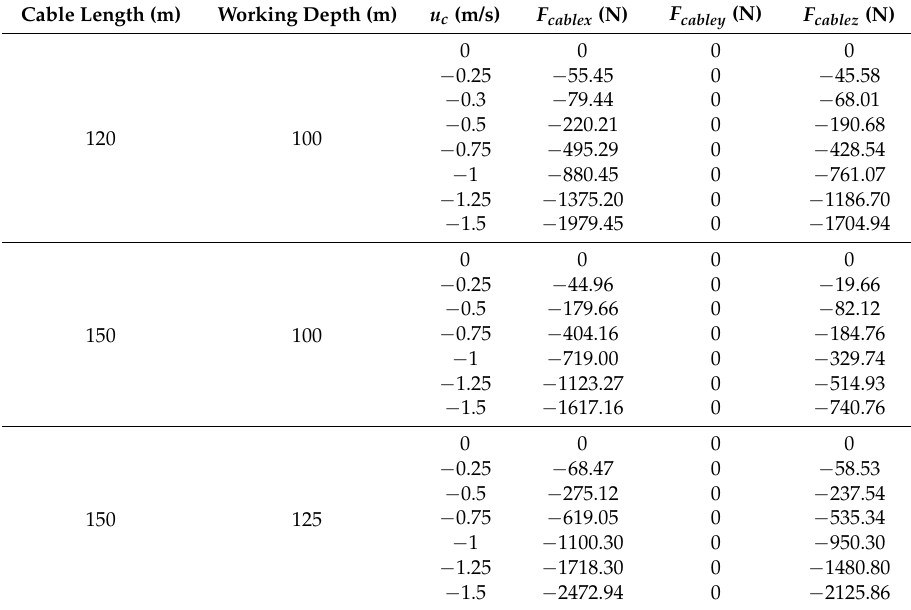
Table 3. Tension on the ROV at the end of the cable under different